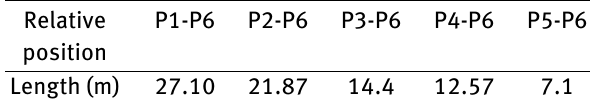
Table 5: Relative position of pressure